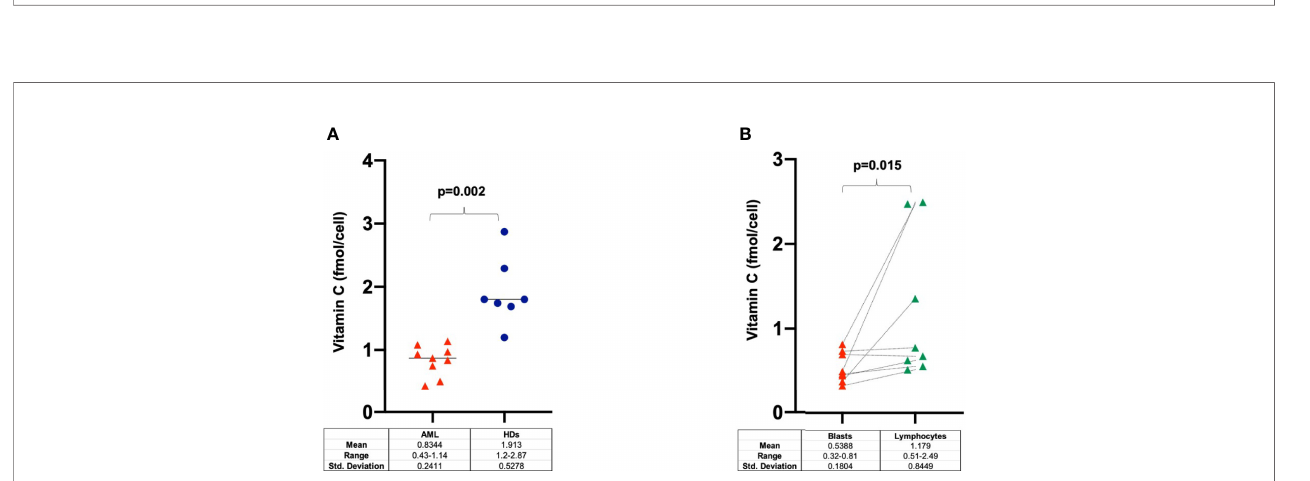
FIGURE 4 | Levels of SLC23A2 , SLC2A1 , SLC2A3 vitamin C transporters (A) and of TET2 transcripts (B) evaluated by RQ-PCR in the PB-MNCs of healthy donors (n=15) or AML patients at diagnosis (n=22). HDs, healthy